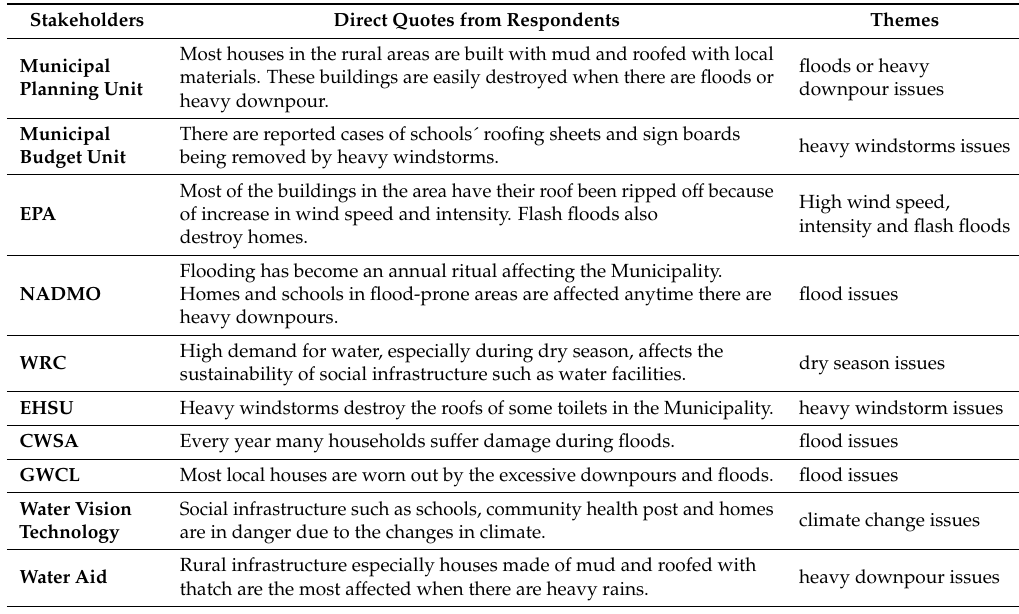
Table 3. Stakeholder perspectives of the impact of climate change on social